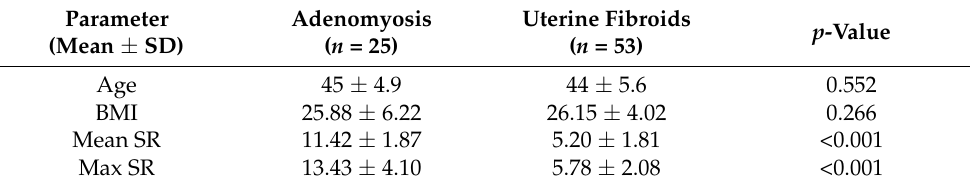
Table 4. Comparison of baseline and strain ratio characteristics between the two study groups Legend: SD = standard deviation, BMI = body mass index and SR = strain